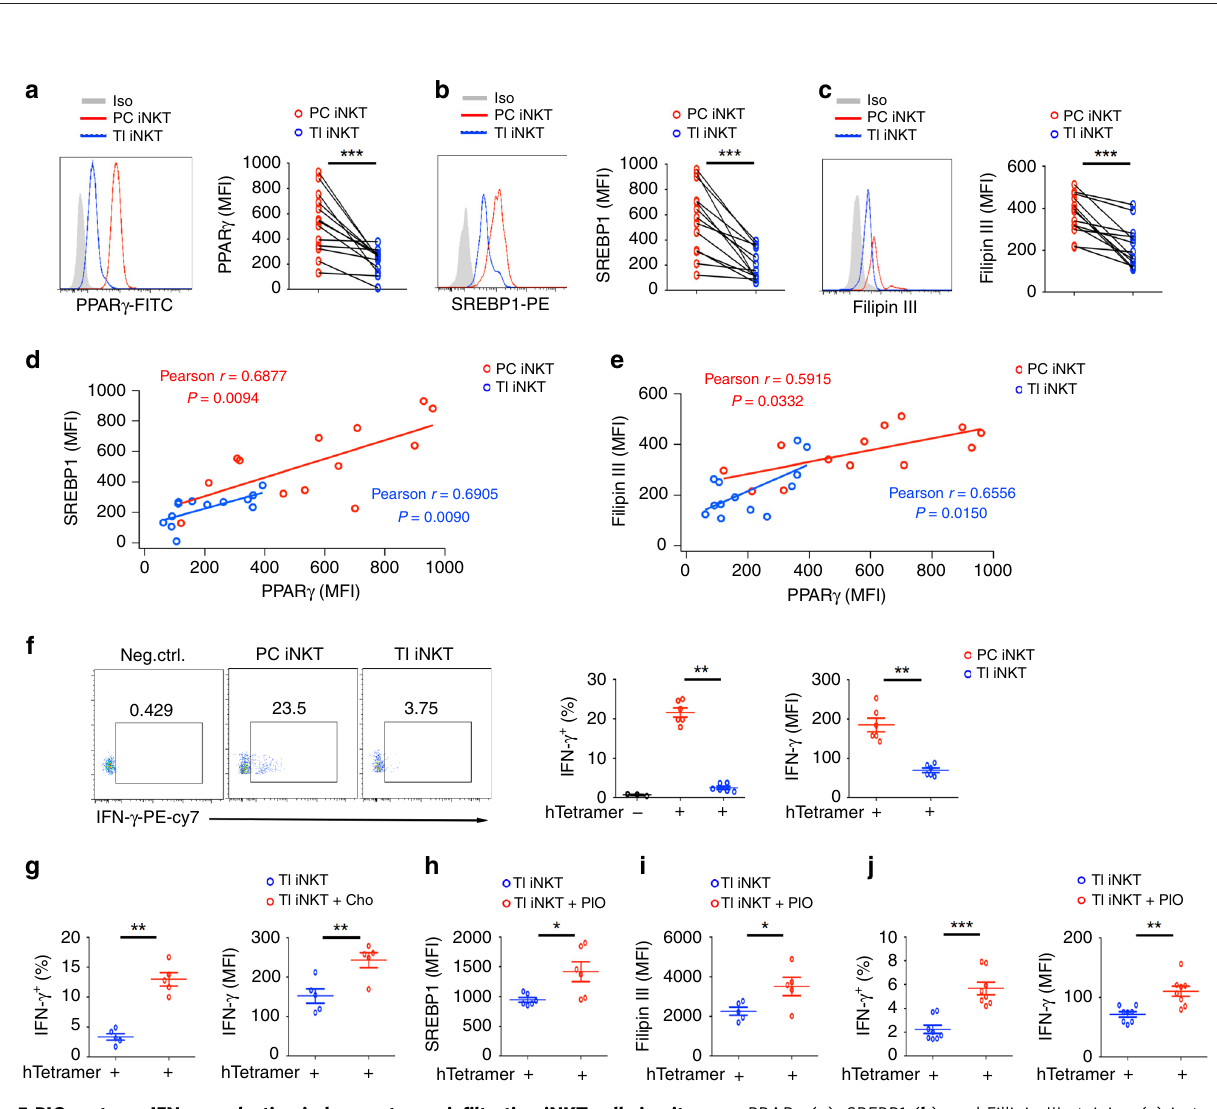
Fig. 5 PIO restores IFN- γ production in human tumor-in fi ltrating iNKT cells in vitro. a – c PPAR γ ( a ), SREBP1 ( b ), and Fillipin III staining ( c ) in tumor- in fi ltrating (TI) and para-carcinoma (PC) iNKT cells from HCC patients. d , e Correlations between PPAR γ and SREBP1 ( d ), PPAR γ and Fillipin III ( e ), in TI and PC iNKT cells as described in a . f Intracellular IFN- γ staining (left), percentages of IFN- γ + iNKT cells (middle), and mean fl uorescence intensity (MFI) of anti-IFN- γ (right) in TI and PC iNKT cells from HCC patients. g In fl uences of water-soluble cholesterol on percentages of IFN- γ + iNKT cells and MFI of anti-IFN- γ in TI iNKT cells from HCC patients. h – j In fl uences of PIO on SREBP1 expression ( h ), Filipin III staining ( i ), and percentages of IFN- γ + iNKT cells and MFI of anti-IFN- γ ( j ) in TI iNKT cells from HCC patients. Data are means ± SEM of 13 patients ( a – c ), 6 patients ( f, h ), 5 patients ( g , i ), or 8 patients ( j ). Data were analyzed by paired student ’ s t -test ( a – c ), Mann – Whitney test ( f – j ), or Pearson ’ s correlation test ( d , e ). * P < 0.05, ** P < 0.01, *** P < 0.001. Source data are provided as a Source Data fi